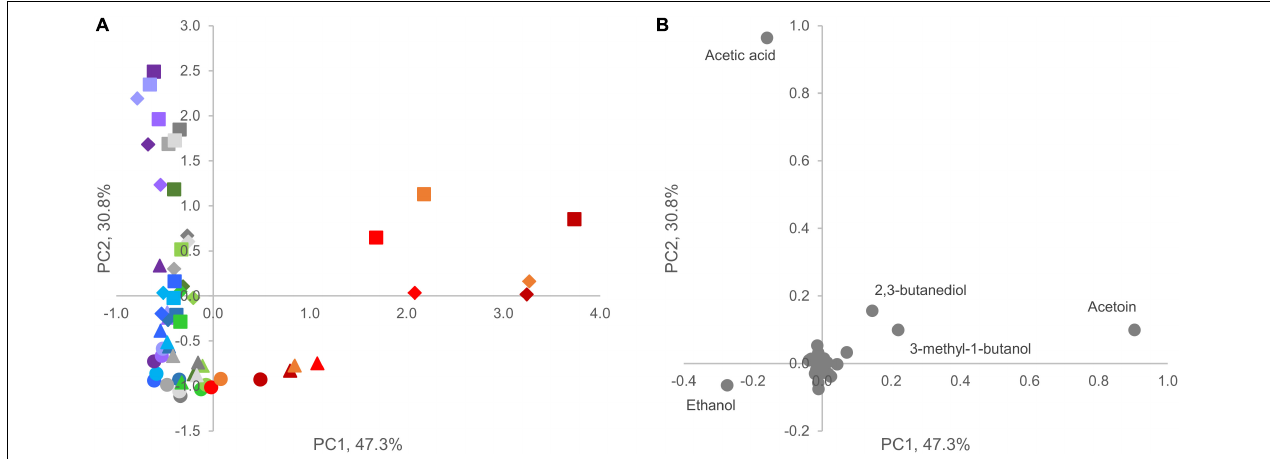
FIGURE 6 | Principal component analysis plot ( PC1 vs. PC2) of VOC profiles in A (blue), B (violet), C (green), D (red), and E (gray) samples. (A) Score plot of cooked ham samples; circles, triangles, diamonds, and squares indicate different sampling times (0, 4, 8, and 12 days, respectively). (B) Loading plot of volatile molecules. Compounds with highest loading value in PC1 vs. PC2 are